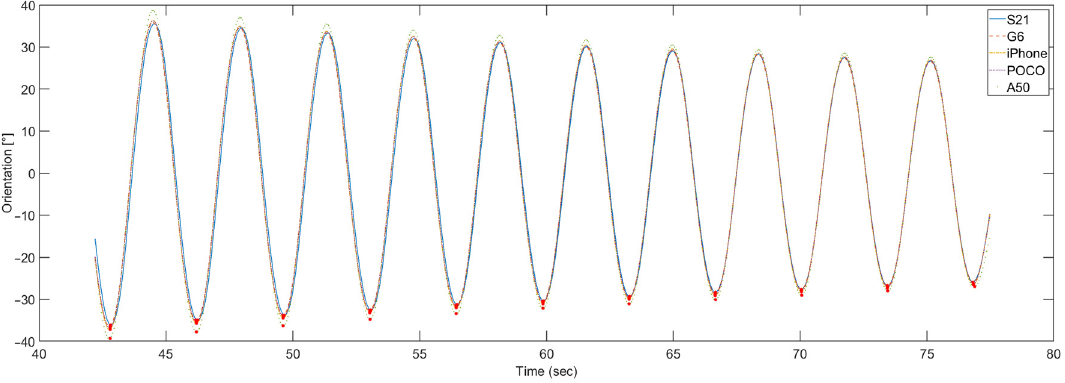
Figure 22. Ten pendulum periods of calculated orientation for all five smartphones.